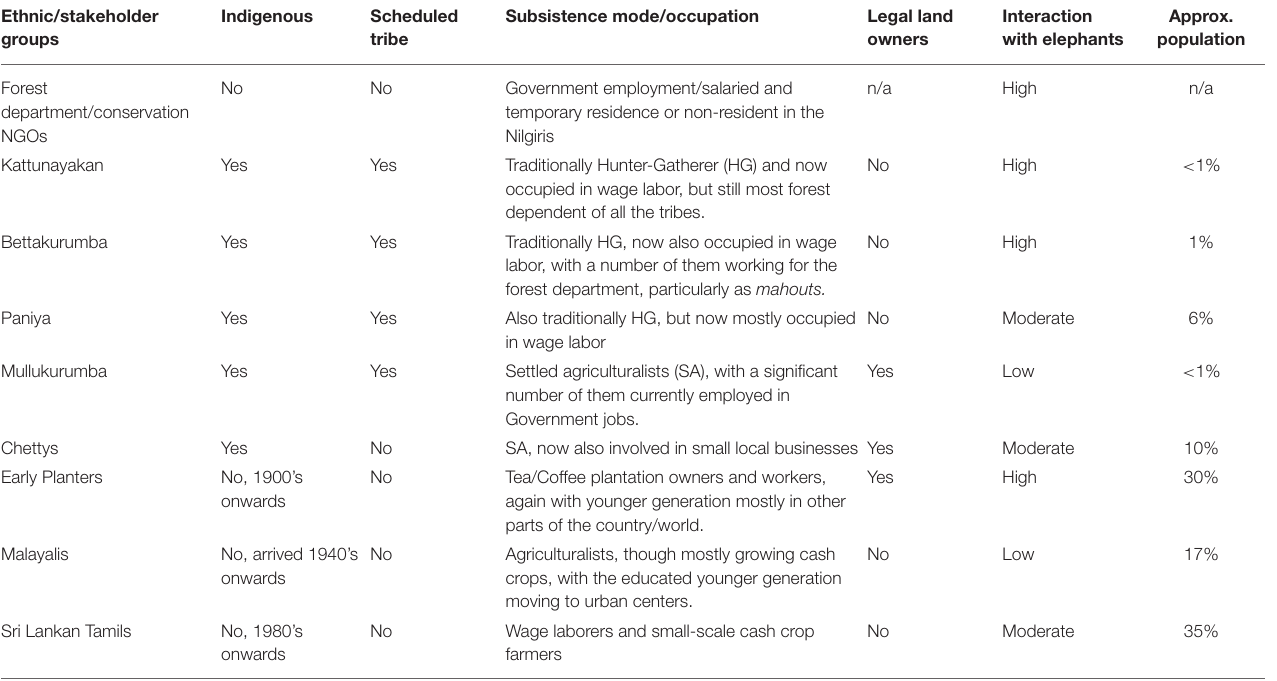
TABLE 1 | Summary of ethnic